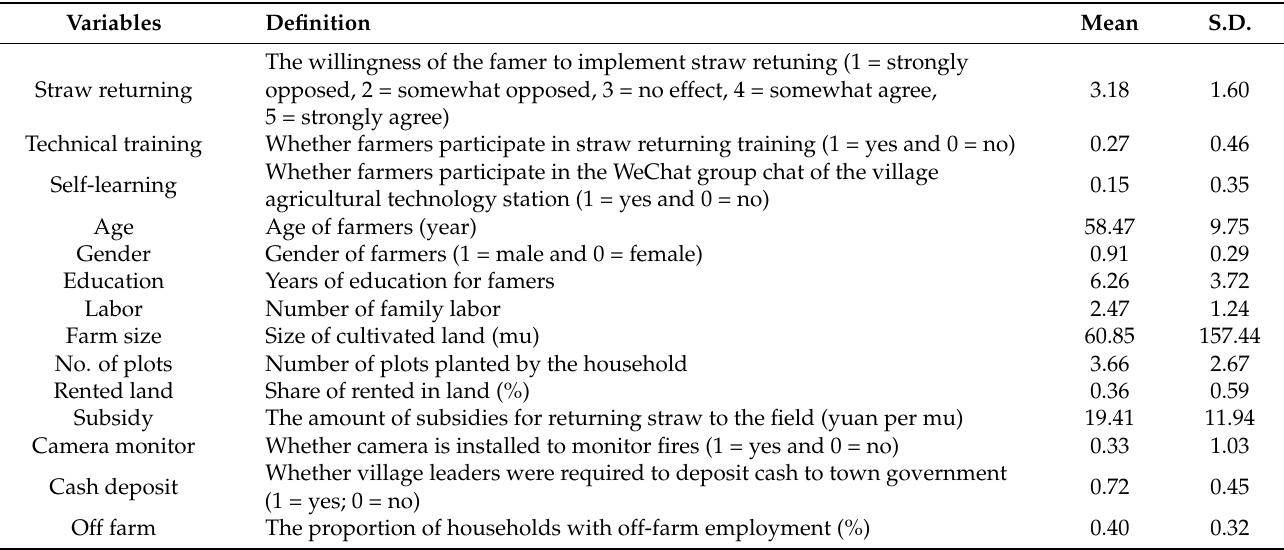
Table 1. Descriptive statistics of variables.